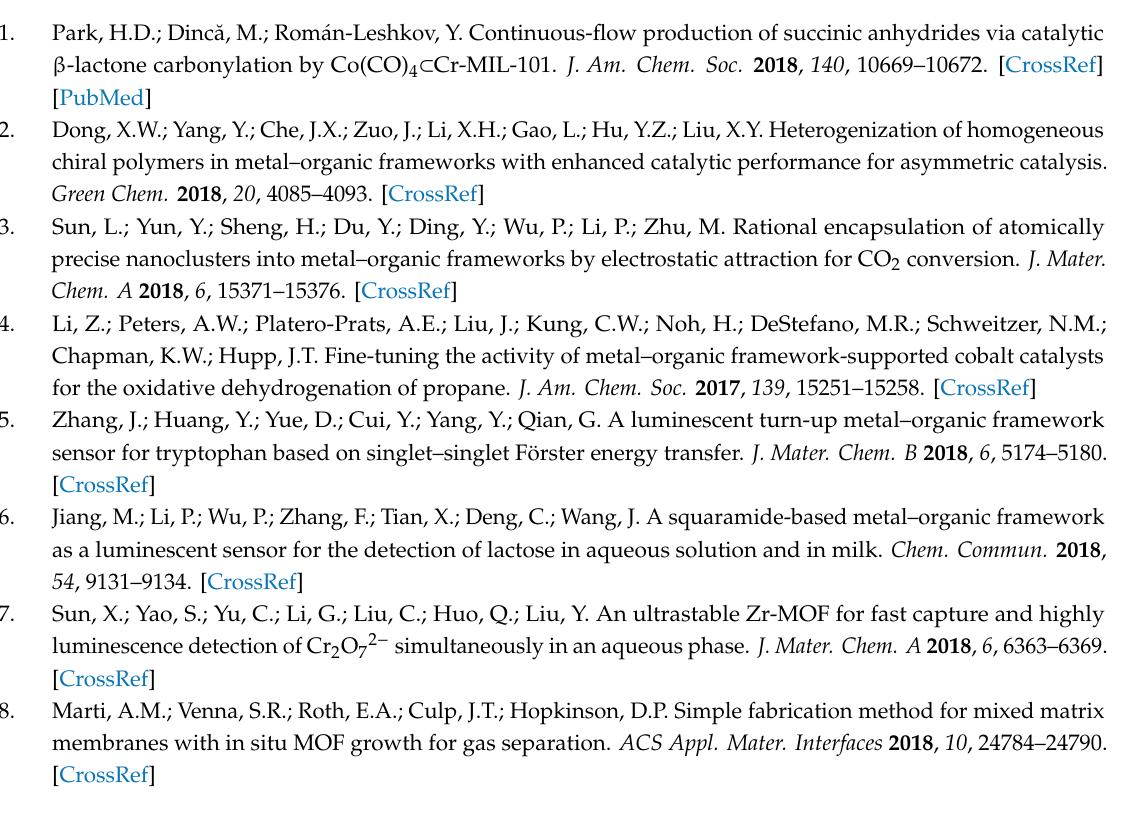
Figure S4: UV-Vis absorption spectra of compounds 1 and 2 aqueous solutions; Figure S5: The powder XRD patterns of compound 1 ; Figure S6: The powder XRD patterns of compound 2 ; Figure S7: Reusability of compound 2 on the PO conversion; Table S1: Crystallographic data and structure refinement details; Table S2: Selected bond lengths (Å) and angles (deg), 1 H NMR characterization